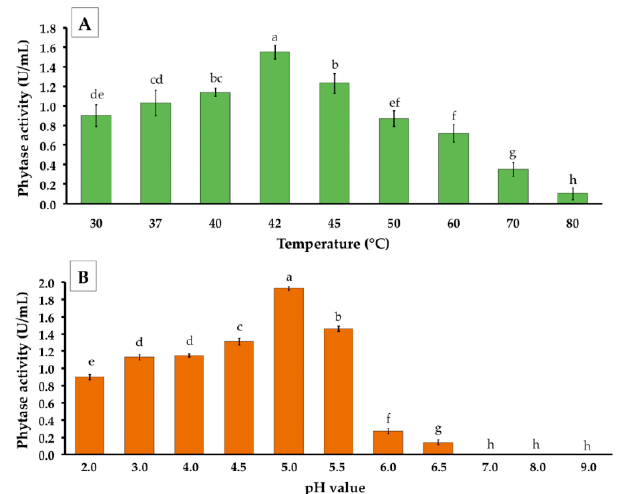
Figure 6. Partial characterization of phytase activity from P. adiposa during enzymatic reactions on phytase activity. ( A ) E ff ect of incubation temperature. ( B ) E ff ect of di ff erent pH values. The results are means ± SD. Di ff erent letters above each bar in the same parameter indicate the significant di ff erence ( p <